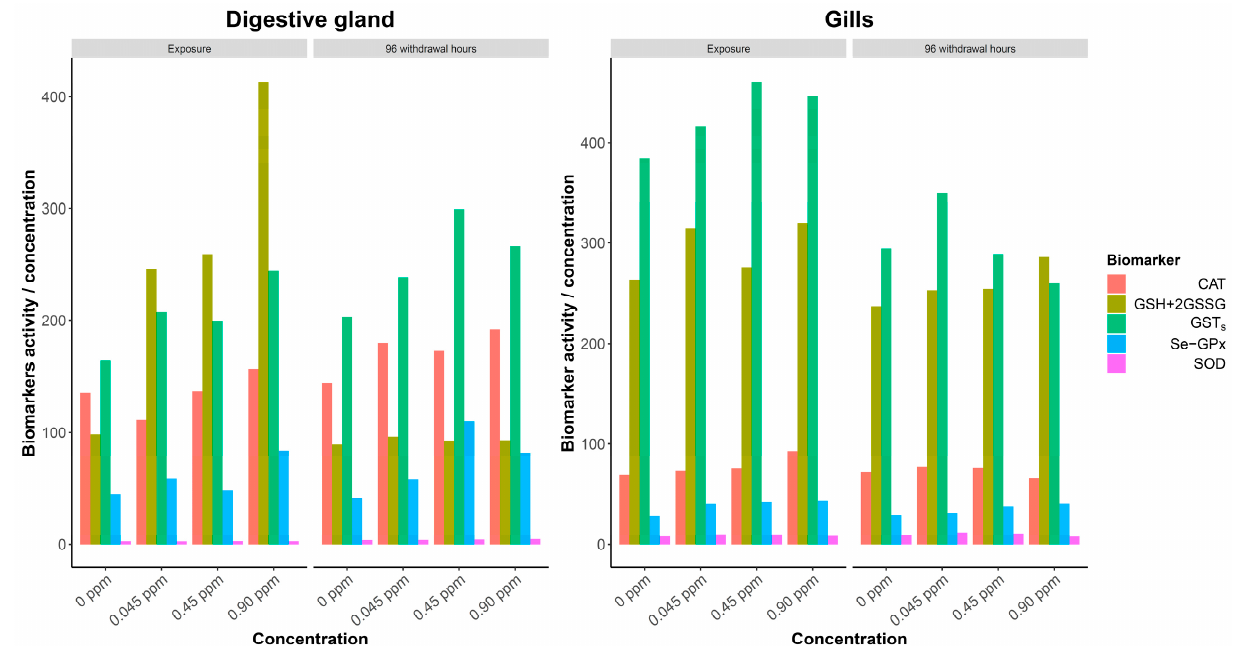
Figure 2. Biomarker estimated levels in the digestive gland and in the gills ( left and right , respectively). Time (i.e., the difference between exposure and recovery phase) was highly significant ( p < 0.001) for all of the investigated enzymes measured in the digestive gland: SOD, CAT, Se-GPx, and GSTs increased their activities moving from the exposure to the recovery phase, whereas the GSH+2GSSG content decreased, i.e., 120.37 during exposure and 76.41 during recovery, respectively (Table 1 and Figure 2). As far as the biomarkers measured in the gills, time was found to be significant for SOD and Se-GPx, which increased their activities from exposure to recovery, and for GSTs, which decreased their activity (Table 1 and Figure